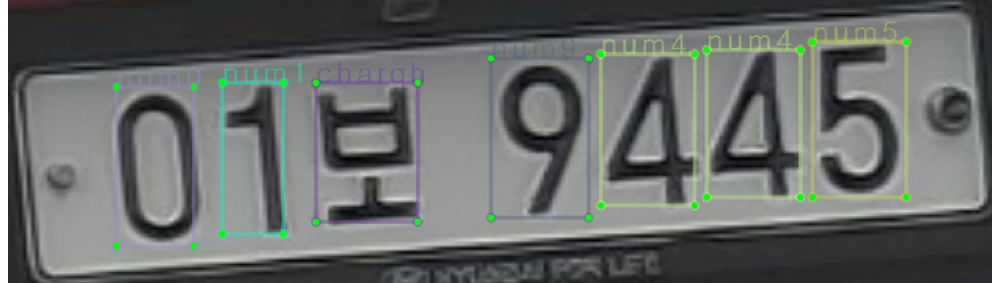
Figure 7. Labeling of LP numbers and characters to be used for phase